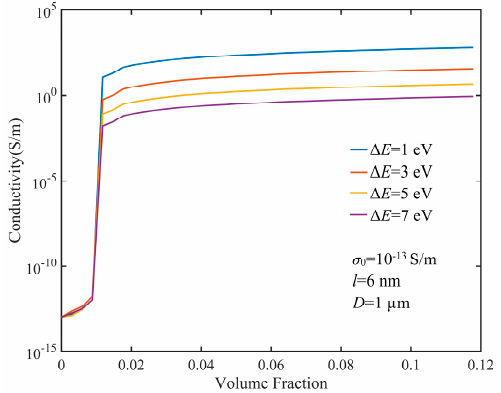
Figure 6. Tunneling effects of different barrier heights on the conductivity of GNP composites.